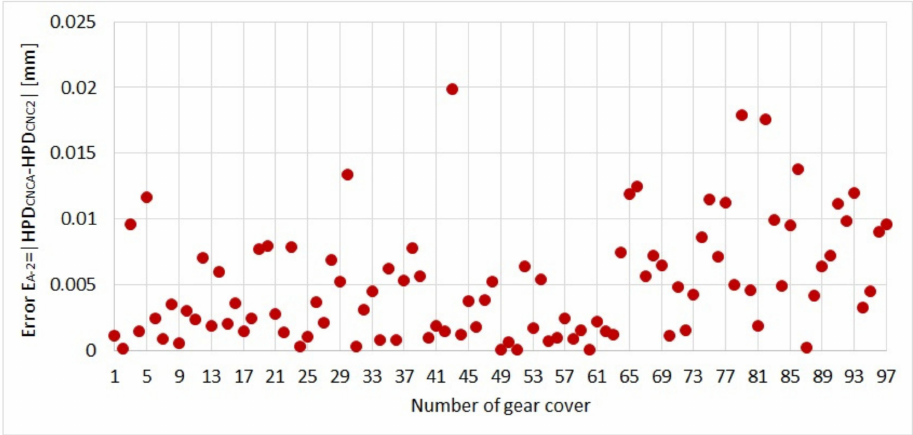
Figure 9. Error E A − 2 for individual